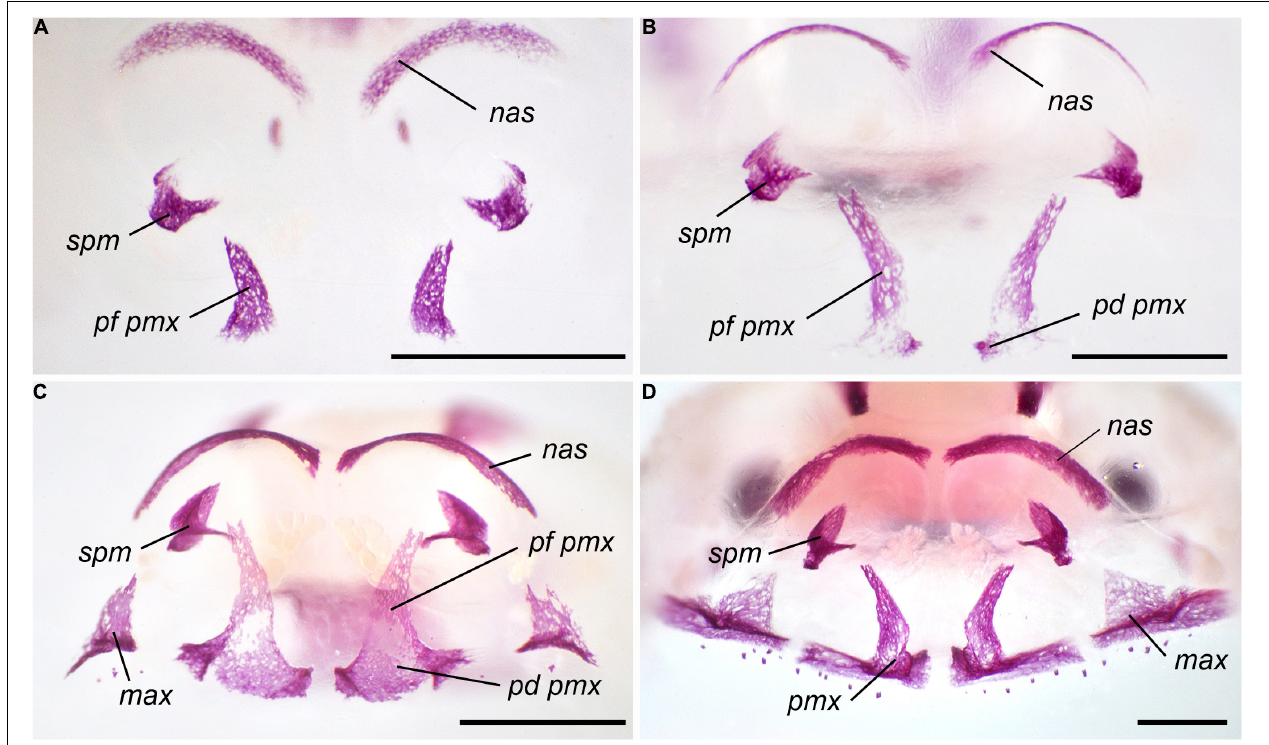
FIGURE 1 | Normal development of the premaxilla in Bombina variegata . (A) Stage 37; (B) Stage 42; (C) Stage 44; (D) Stage 45. Abbreviations: max, maxilla; nas, nasal; pd pmax, dental process of the premaxilla; pf pmx, facial process of the premaxilla; pmx, premaxilla; spm, septomaxilla. Scale bar 1 mm.